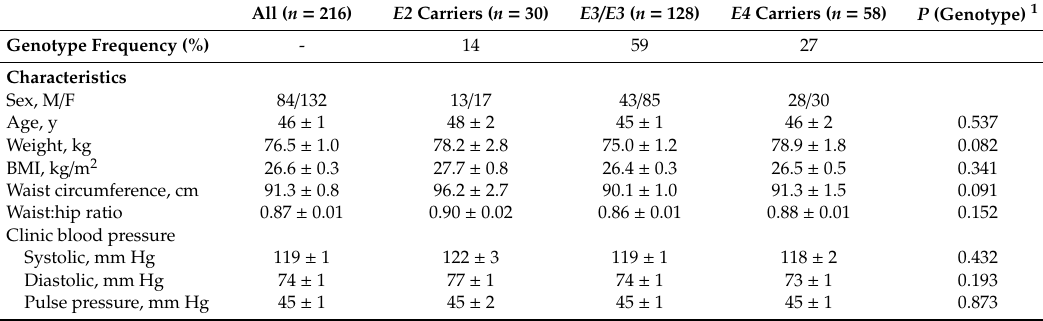
Table 1. Baseline characteristics in the combined study group and according to the APOE genotype. All ( n =